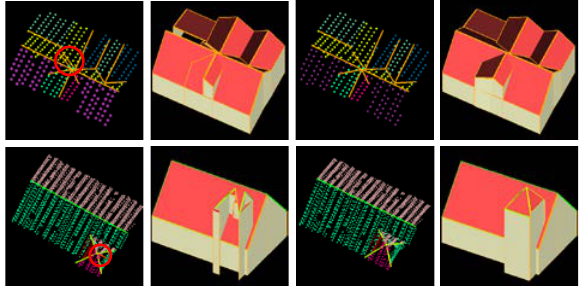
Figure 8. Two often wrong reconstructed buildings in the Vaihingen dataset. 1) Roof segments and ridges without correction; 2) Reconstructed models from 1); 3) Roof segments and ridges with correction; 4) Reconstructed models from 3).